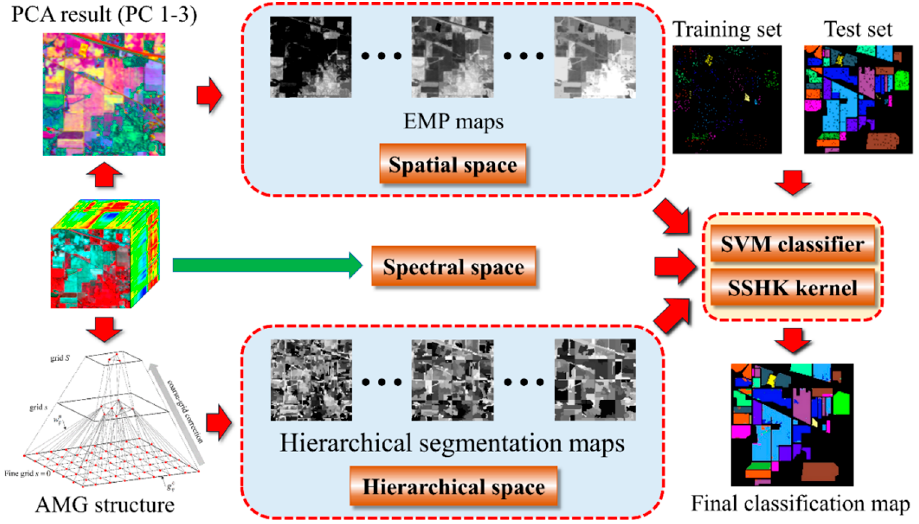
Figure 2. Schematic diagram of the SVM-SSHK method.